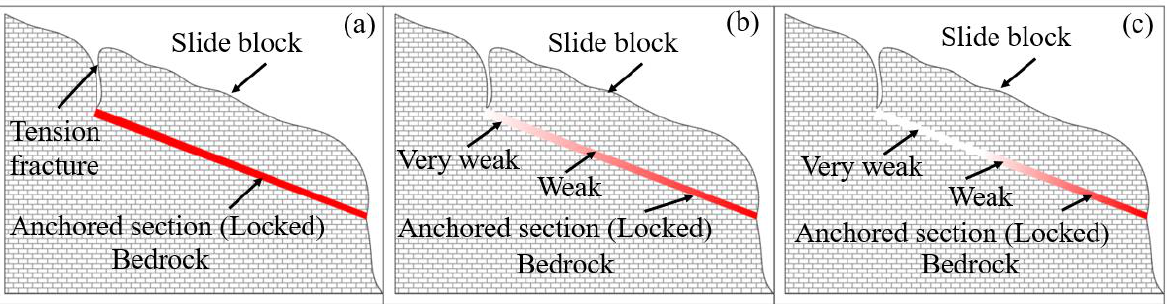
Figure 1. Evolutionary model of advancing layered rock landslide: ( a ) undamaged stage; ( b ) initial stage of damage; ( c ) end stage of damage.